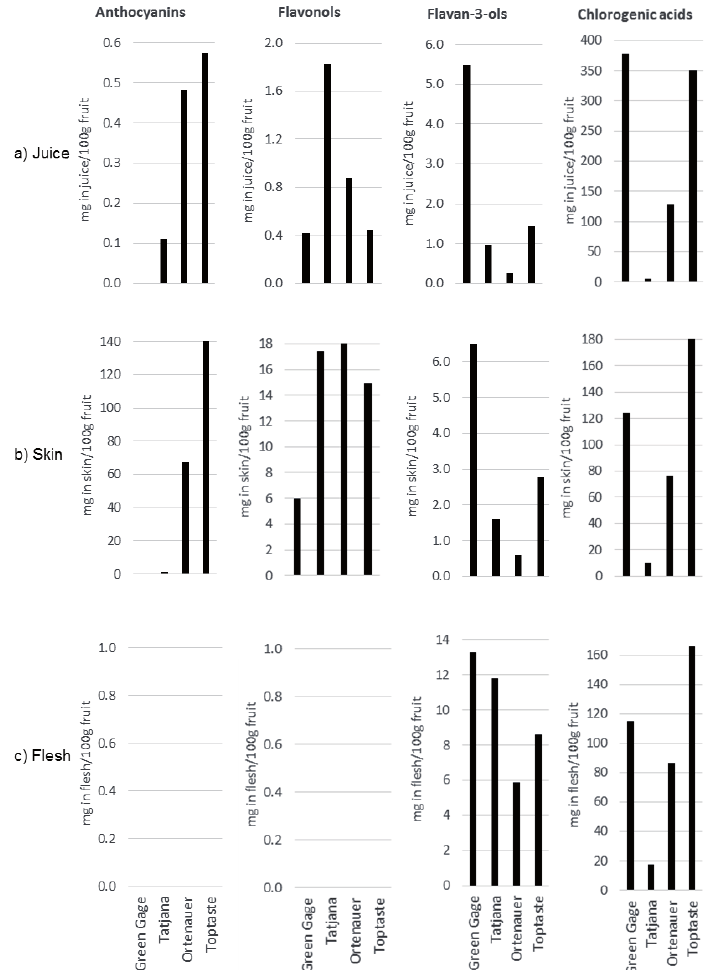
Fig. 1: Phenolic profiles of plum fruit juices (a) in comparison to fruit skin (b) and fruit flesh (c). Data of (b) and (c) are calculated from t reutter et al (2012) and J aiswal et al. (2013),